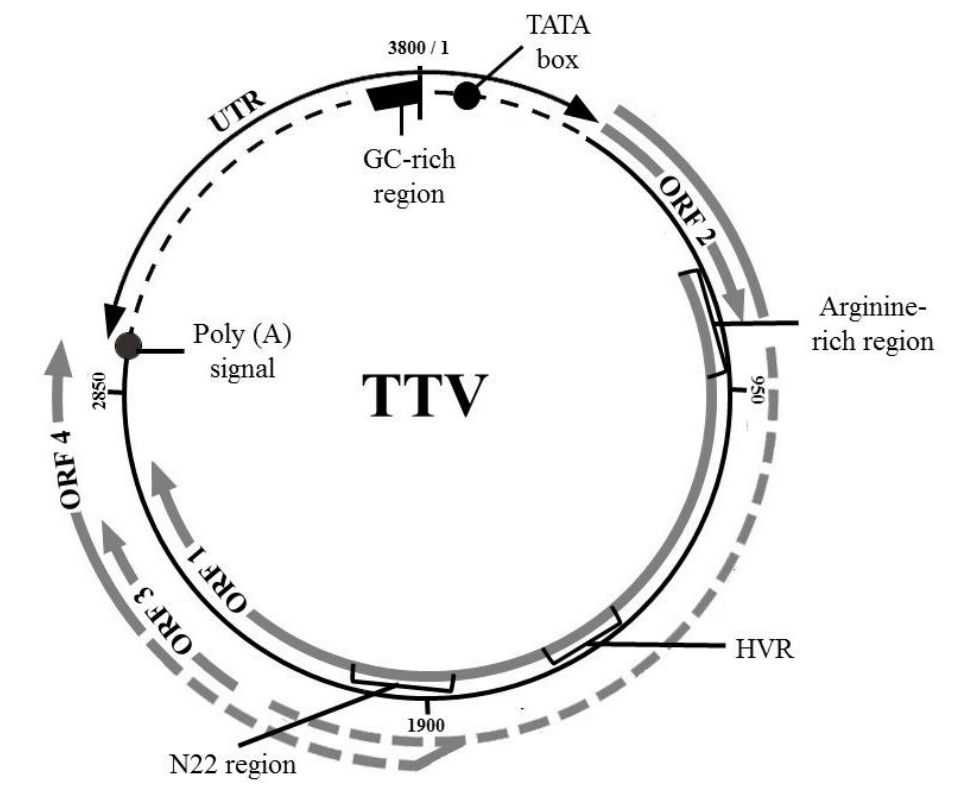
Figure 1 : The diagram illustrate the molecular and genomic organization of TTV (Hsiao et al., 2016). Adapted from Jarkasi et al.,